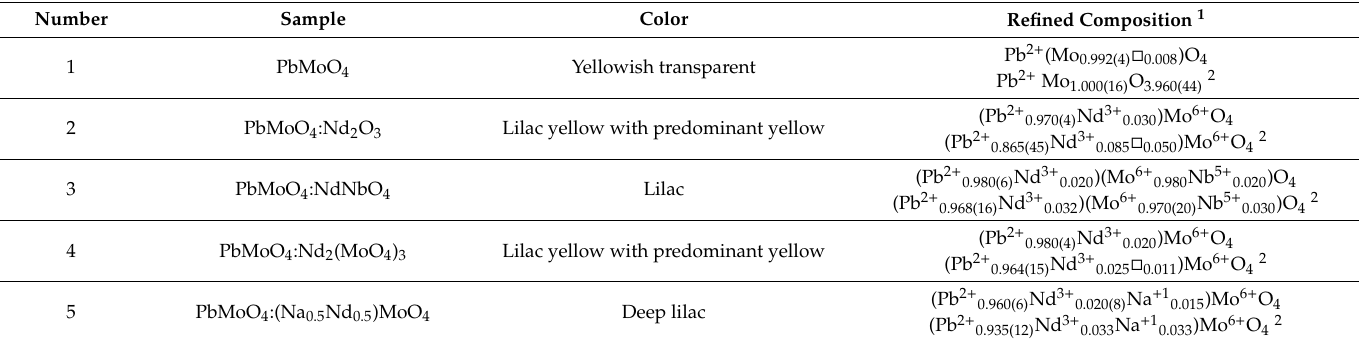
Table 3. Color and refined compositions of PbMoO 4 and PbMoO 4 :Nd 3 + crystals according to single-crystal X-ray (XRD) and neutron di ff raction (ND)